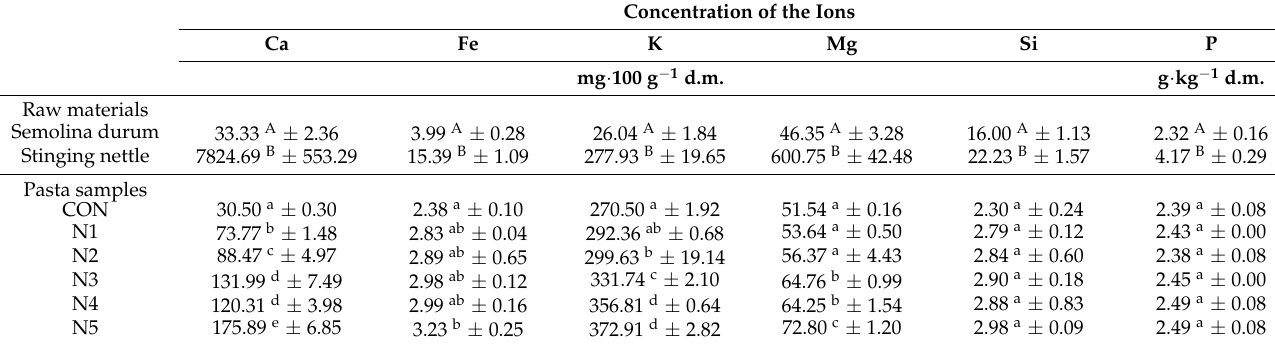
Table 3. Concentration of the ions in the raw materials and uncooked pasta samples. Concentration of the